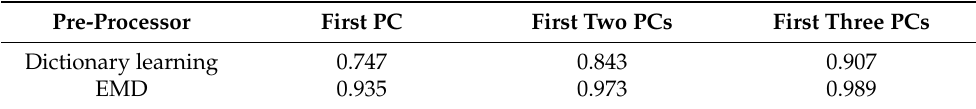
Table 3. Contribution rate of first few principal components in case 2.